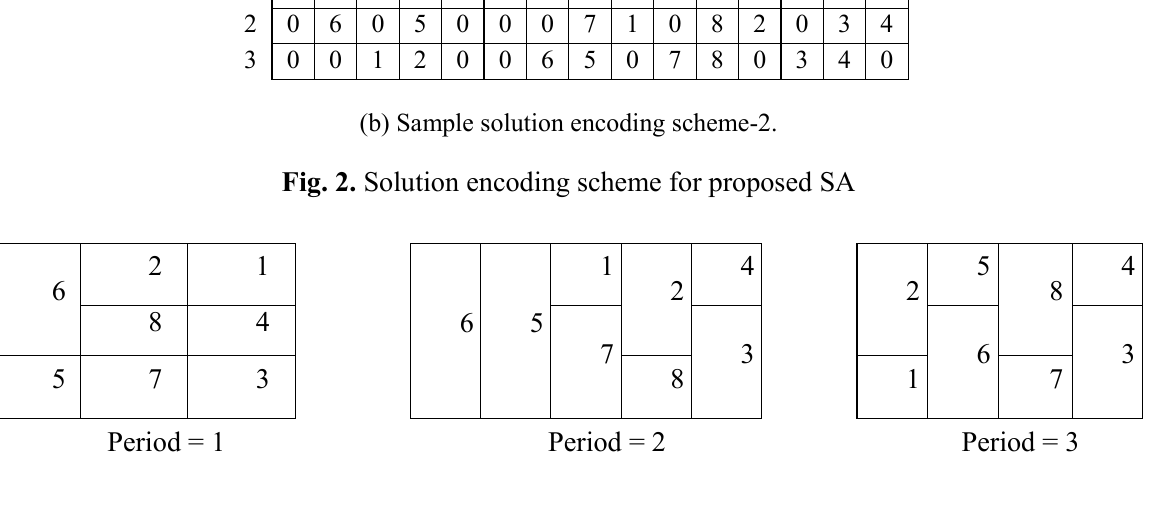
Fig. 3. Flexible bay structure layout configurations for solution encoded scheme shown in Fig.